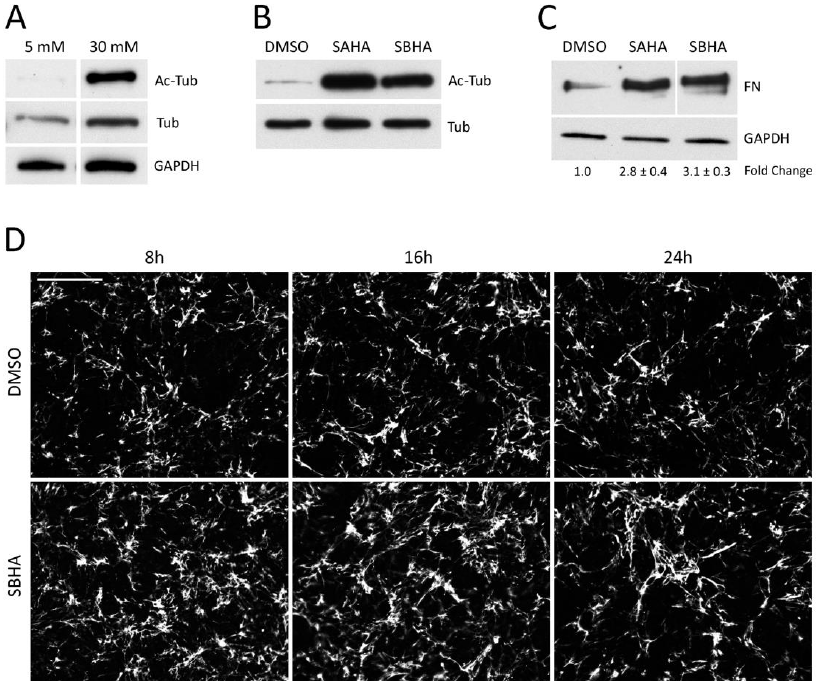
Figure 1. Increased acetylation promotes fibronectin (FN) matrix assembly. ( A ) Mesangial cells grown in 5 mM or 30 mM glucose for 48 h were lysed in RIPA buffer. ( B,C ) Mesangial cells grown in 30 mM glucose were treated with either 5 μM suberoylanilide hydroxamic acid (SAHA) or suberohydroxamic acid (SBHA) or DMSO (vehicle control) in medium containing 20 μg/mL human plasma FN for 24 h before lysis in deoxycholate (DOC) buffer. ( A,B ) RIPA and DOC-soluble lysates were immunoblotted with antibodies against acetyl-tubulin (Ac-Tub), tubulin (Tub) or GAPDH as indicated. ( C ) The DOC-insoluble fraction was immunoblotted with HFN7.1 anti-FN monoclonal antibody. Fold-changes are the average of three independent experiments ( p < 0.01 for treatment compared to DMSO). Representative blots are shown and samples in each panel are from the same blot and exposure time. ( D ) Mesangial cells were grown as in (B,C) for 8 h, 16 h, and 24 h before staining with HFN7.1 antibody. The mean fluorescence intensity of 6 randomly selected fields per condition was measured using Image J software. Three independent experiments were quantified and average fold-changes were calculated of SBHA samples relative to DMSO samples. Mean ± SEM values are 1.36 ± 0.14 at 8 h, 1.20 ± 0.07 at 16 h, and 1.15 ± 0.05 at 24 h. Representative images are shown for each condition. Scale bar = 50 μm.